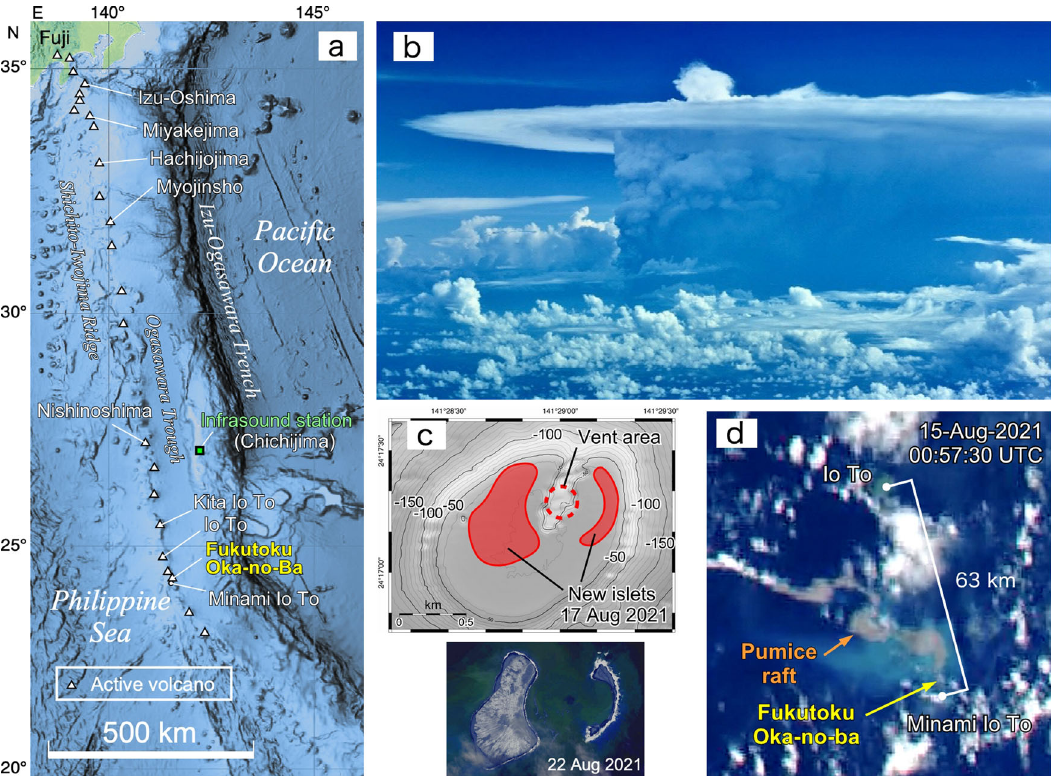
Fig. 1 Outline of the 2021 Fukutoku-Oka-no-Ba (FOB) eruption. a Location map for FOB volcano. Bathymetry data from NOAA ’ s National Centres for Environmental Information. b Photo of the eruption at ~15:00 JST on 13 August 2021, taken from 6000 m above sea level and ca. 90 km north of FOB by the Japan Coast Guard. c Bathymetry around FOB prior to the 2021 eruption 55 . The new islets and the vent area are indicated by red areas and the dashed line, respectively. Photo by GeoEye-1 (Maxar Technologies) on 22 August 2021. d Distribution of the pumice raft (grey zone) extending from the source; image from photo by Himawari-8 (JMA, processed by the Digital Typhoon Project of NICT) at 09:57:30